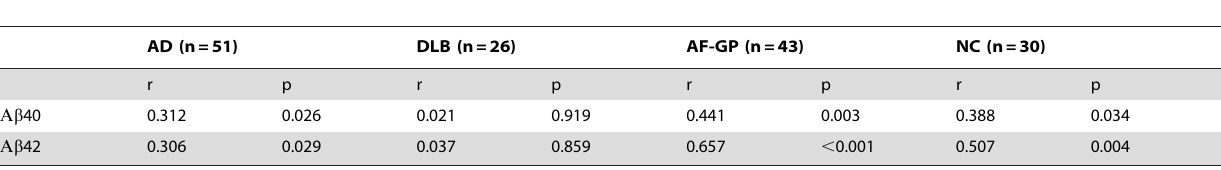
Table 3. Correlations between CSF CysC and CSF Ab 40 and Ab 42 levels.